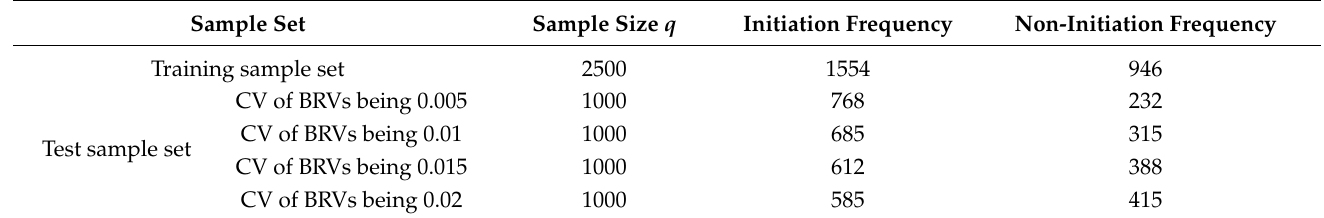
Table 4. The statistical results of the initiation and non-initiation frequencies of Composition B in the training sample set and test sample sets under the shock load condition where v is 1050 m/s.